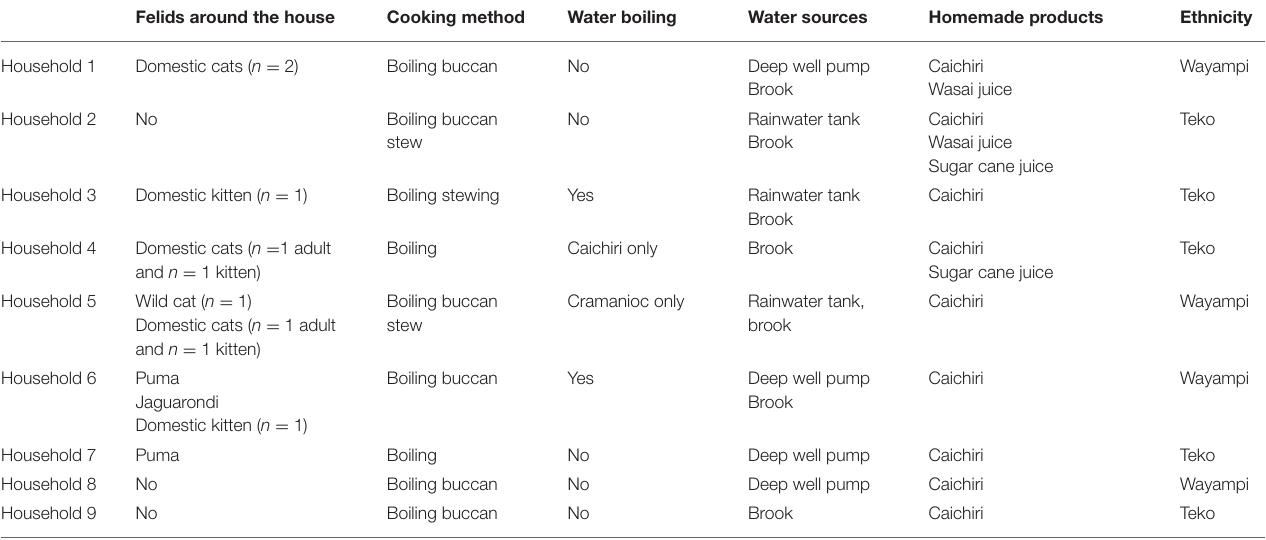
TABLE 3 | Risk factors of toxoplasmosis of the 9 infected households, Camopi, French Guiana. Felids around the